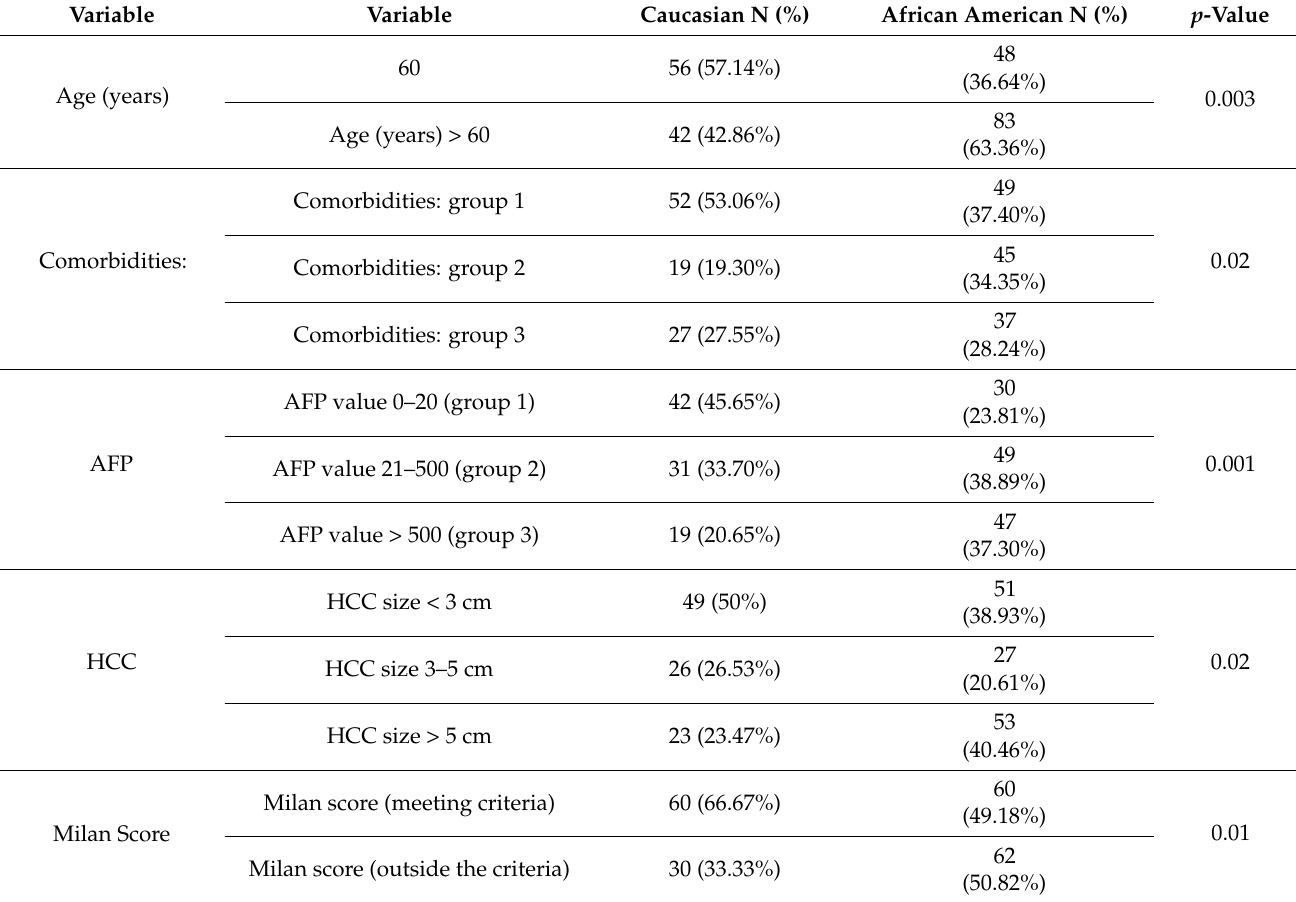
Table 1. Patient characteristics for the whole study cohort at HCC